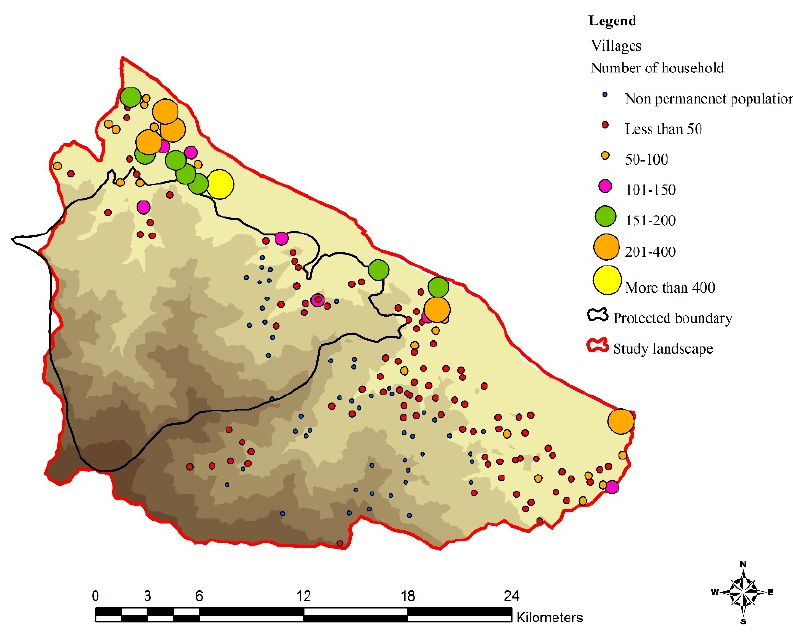
Figure 4. Classification of study villages based on their population, number of households, and geographical distribution across the study landscape